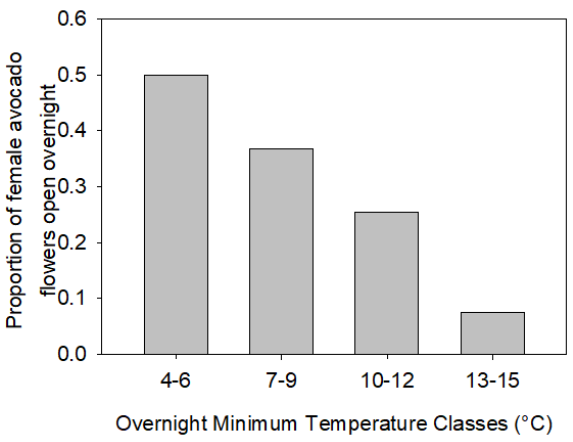
F IGURE 3: The relationship between overnight minimum temperature ranges and the proportion of female ‘Hass’ avocad o flowers that remained open overnight. Temperatures are grouped into classes, each encompassing a range of 3°C.